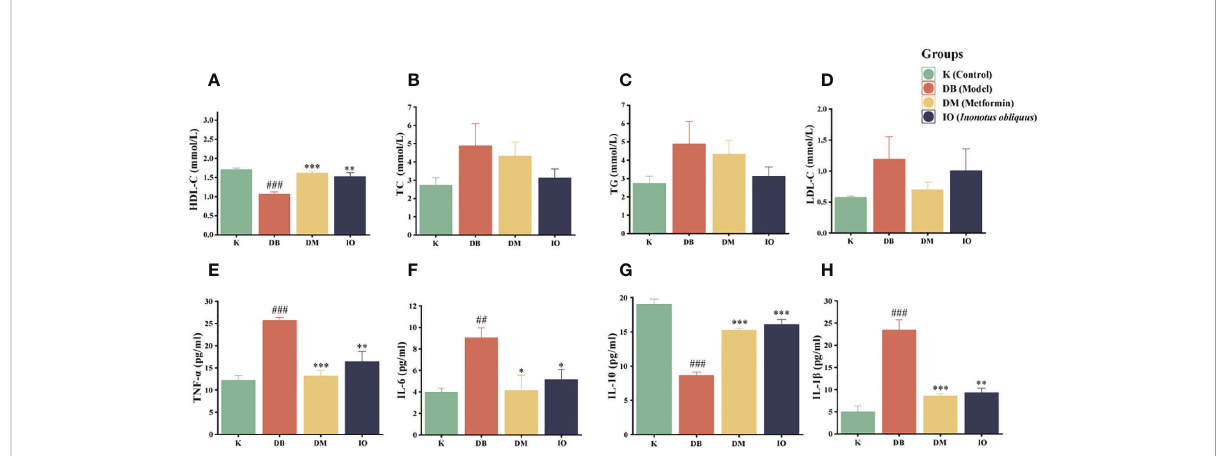
FIGURE 2 Effects of lipid metabolism and in fl ammatory cytokines. HDL-C (A) , TC (B) , TG (C) and LDL-C (D) . TNF- a (E) , IL-6 (F) , IL-10 (G) and IL-1 b (H) in fl ammatory cytokines in the plasma of db/db mice. Data were expressed as the mean ± SD. ### p < 0.001 vs. K, * p < 0.05 vs. DB, ** p < 0.01vs. DB, *** p < 0.001 vs.